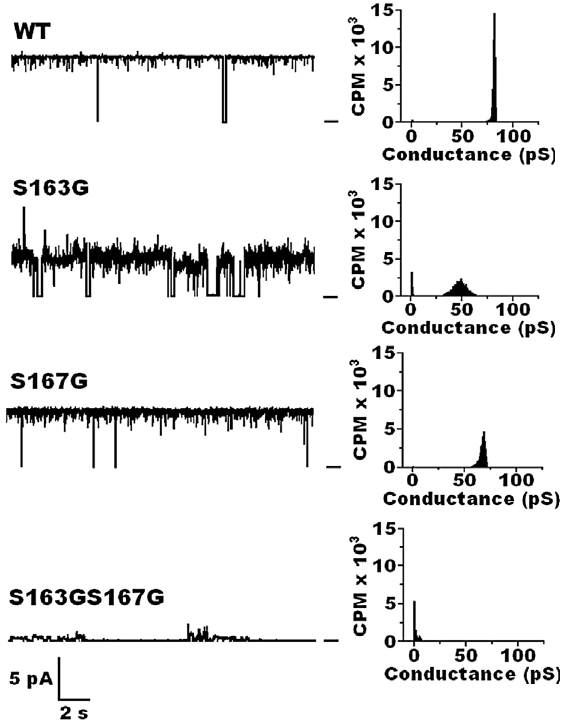
Figure 9. ( Left ) Representative current traces of OmpA wild-type and mutant OmpA proteins isolated from cytoplasmic inclusion bodies of E. coli BL21(DE3) pLysS cells The proteins were incorporated into planar lipid bilayers of 1,2-diphytanoyl- sn -glycero-3- phosphocholine (DPhPC) at room temperature between aqueous solutions of 1 M KCl in 20 mM HEPES, pH 7.4. Bar at right of the traces indicates the closed state of the channel. Clamping potential was +100 mV with respect to ground; ( Right ) Histograms taken